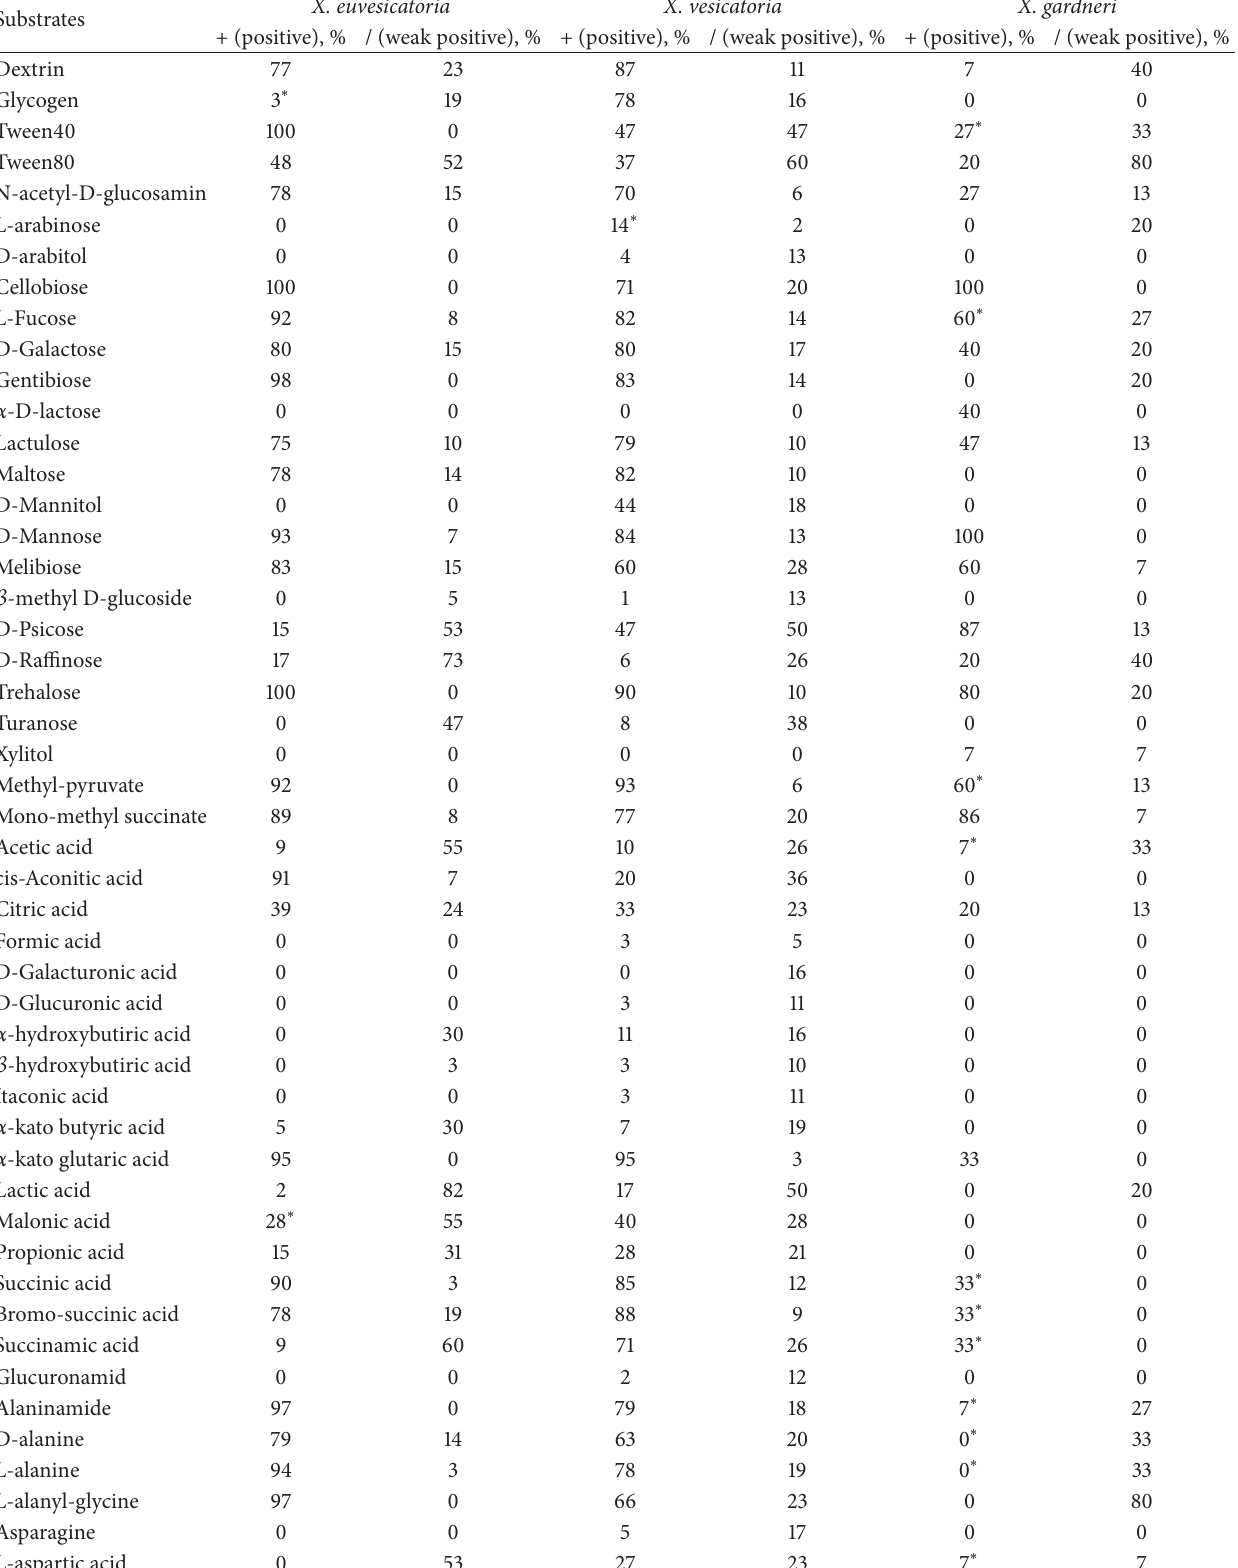
Table 2: Differences in utilization of BIOLOG GN2 substrates by the Bulgarian strains of genus Xanthomonas isolated from pepper, tomato, and weeds.